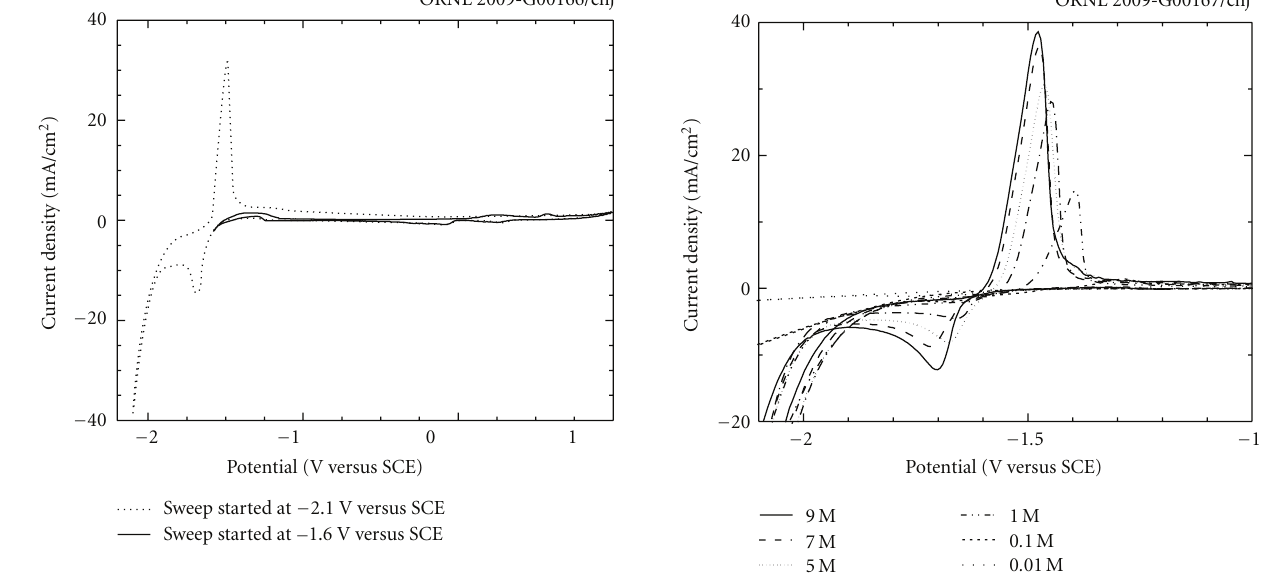
Figure 2: Current density versus applied potential curves for ZnO single-crystal electrode sample 4 (see Table 1) measured in the dark. Neither the cathodic, or anodic peaks are observed if the scan is started at a higher potential than the cathodic peak.